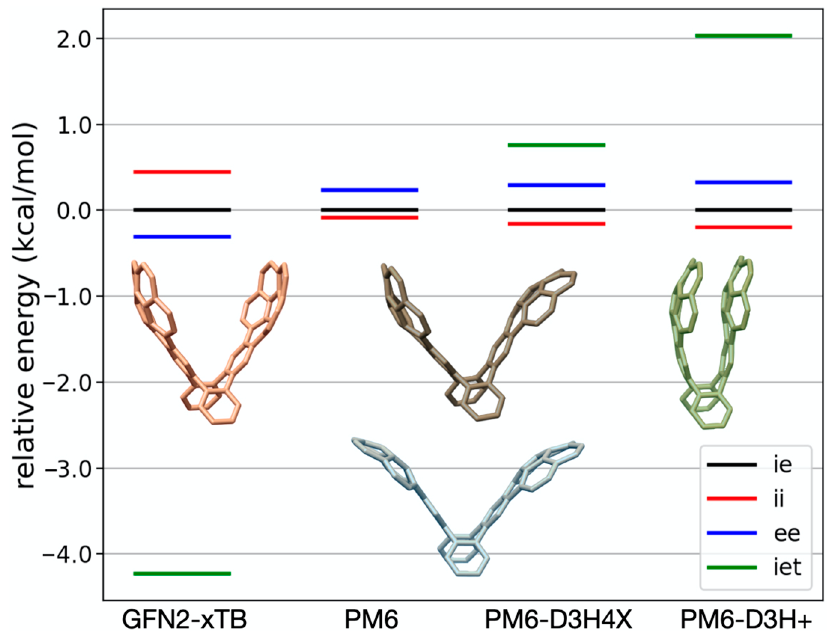
Table 2. Energy di ff erences between conformers of the buckycatcher according to several methods. All values in kcal/mol. CCSD and CCSD(T) calculations evaluated on the PM6-D3H4X geometries, whereas the M06-2X calculations were performed on the GFN2-xTB geometries.